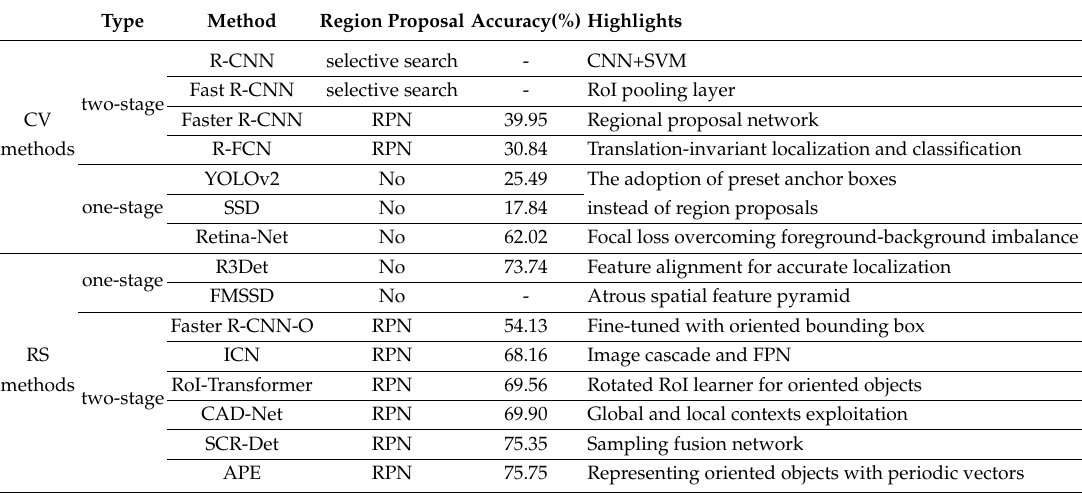
Table 1. Comparison of different remote sensing